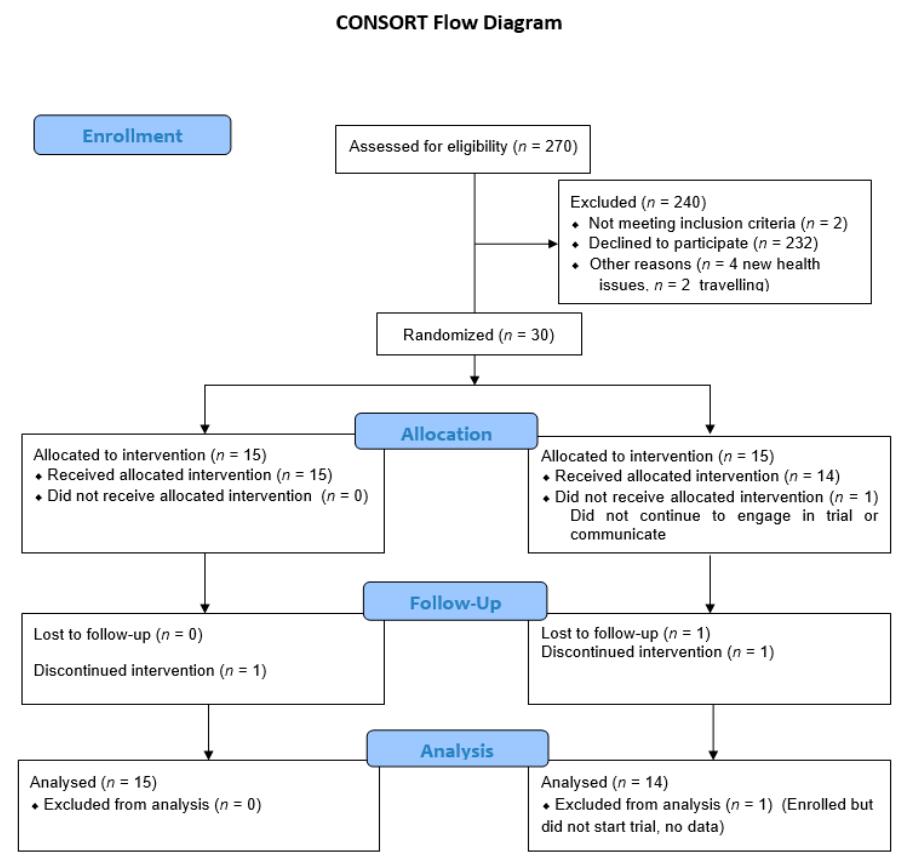
Figure 2. Consort diagram for trial for healthy participants.